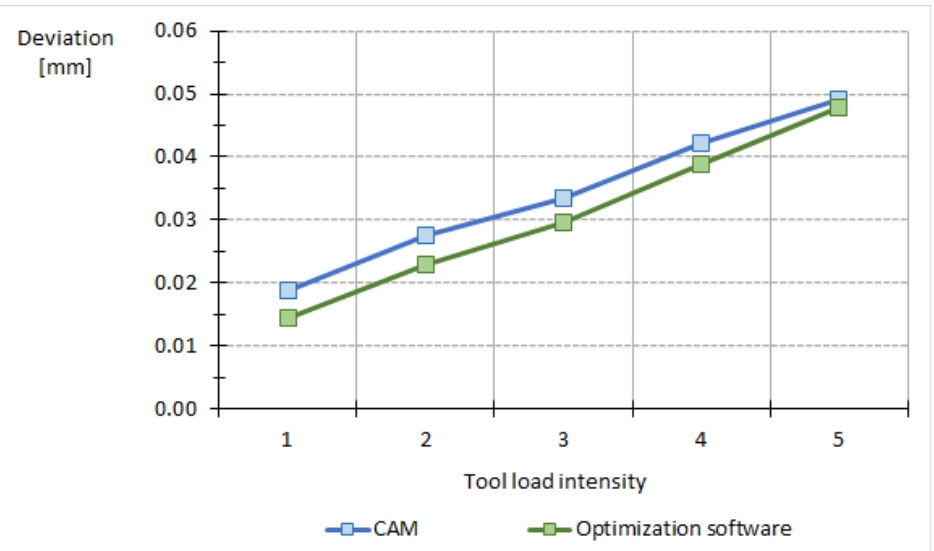
Figure 9. Comparison of mean deviations on the sidewalls of pockets made with CAM and optimi ‐ zation software.